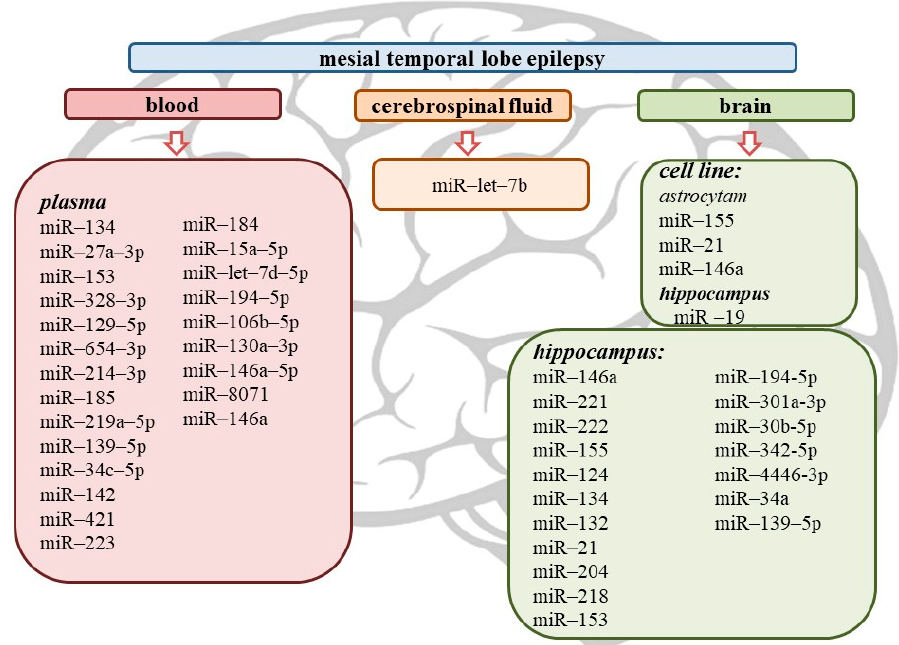
Figure 2. MicroRNA biomarkers for mesial temporal lobe epilepsy.